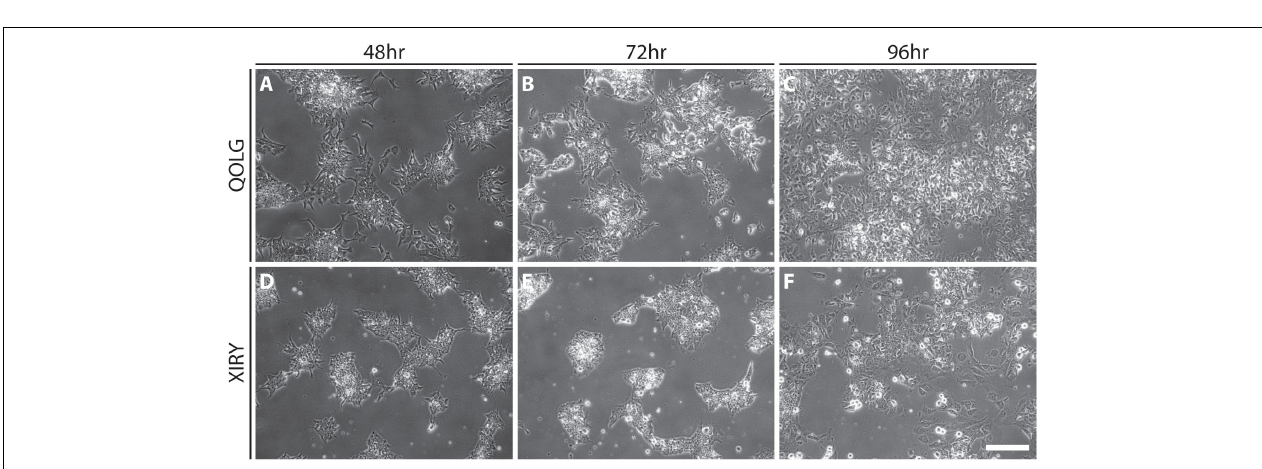
FIGURE 4 | Delaminated neural crest cells have a mesenchymal morphology. Phase contrast images of differentiating hiPSCs cultures taken during neural crest induction at specified time points. Control QOLG (A–C) , mutant XIRY (D–F) . Note that control QOLG cells at 48 h (A) exhibit delaminated cells with mesenchymal morphology, in contrast to XIRY cells which do not show cell delamination until 96 h (F) . Scale bars = 200 µ